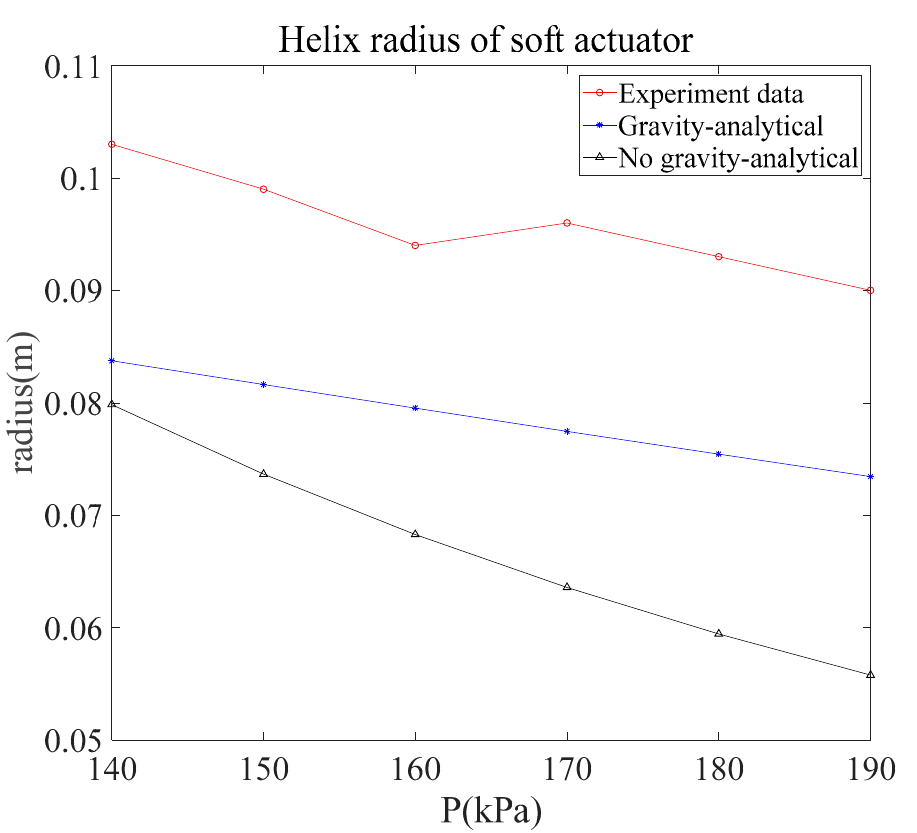
Figure 10. Changes in the helical radius of the twisting module.